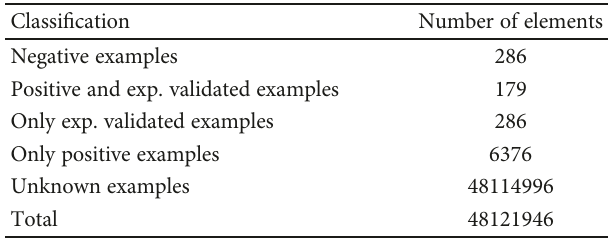
Table 1: Description of the types of samples in our